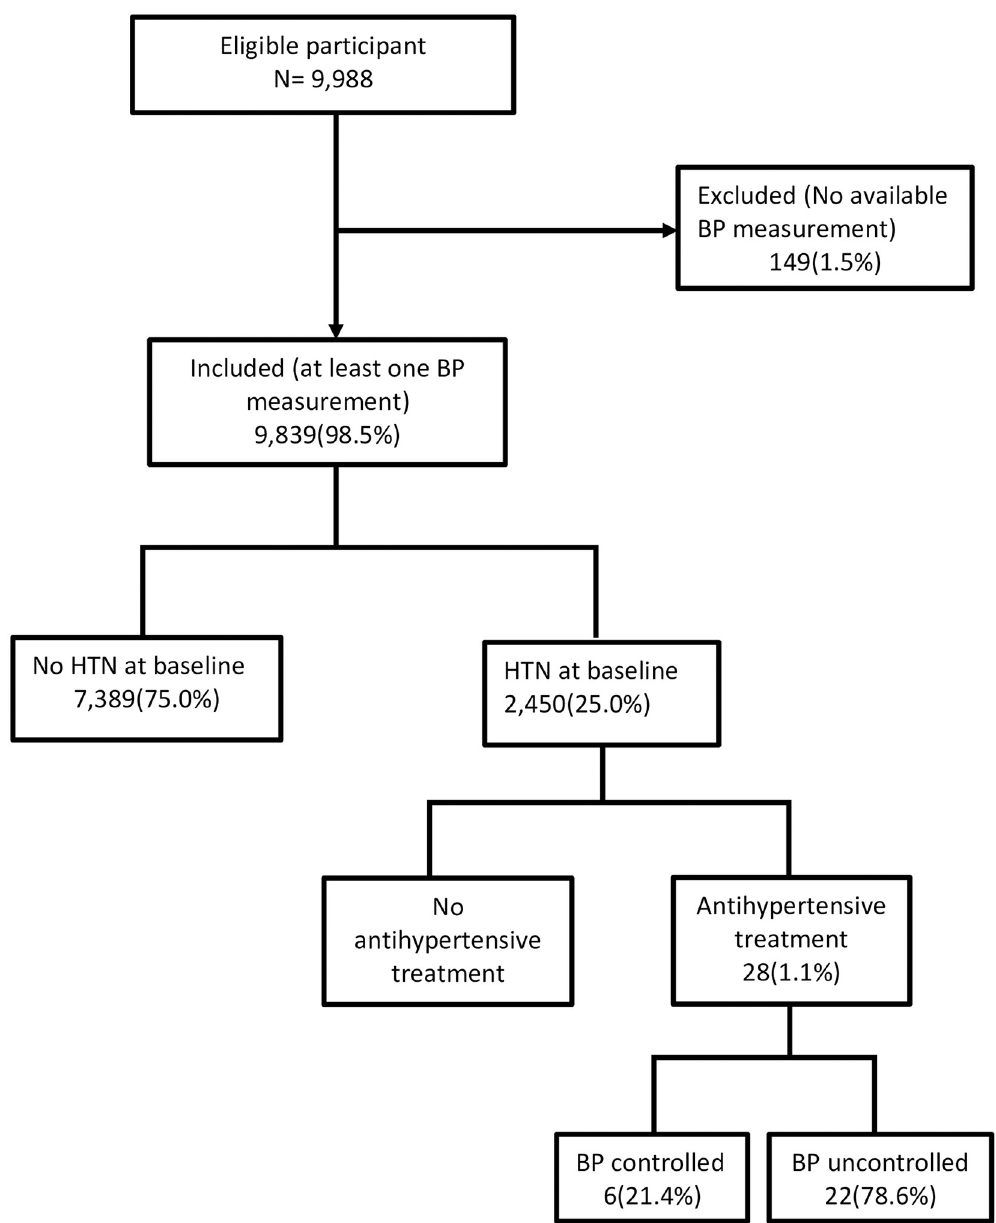
Fig 1. Flow chart of the study participants. BP: Blood pressure, HTN: Hypertension.